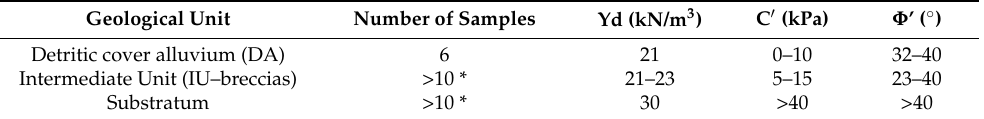
Table 2. Mechanical parameters of the Grand Ilet geological units crossed by the gully of the Ravine de l’Eglise. Yd, dry unit weight; C’, effective cohesion; Φ ’, effective friction angle. These parameters were obtained from laboratory tests carried out in previous studies on samples from Roche à Jacquot and Grand Ilet [62,63]. * Laboratory tests made on multiple samples in Reunion for similar